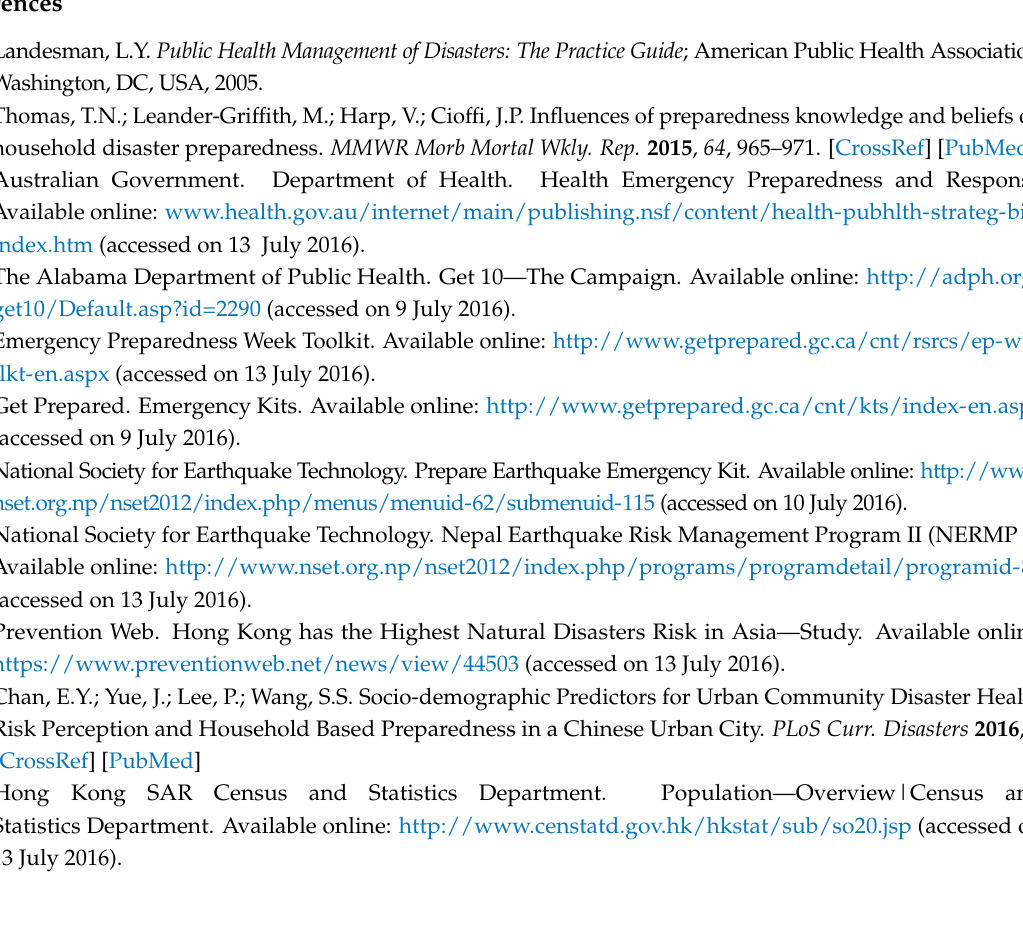
Supplementary Materials: The following are available online at http://www.mdpi.com/1660-4601/15/8/1598/ s1, Figure S1: The proportion of individuals against the number of household preparedness items (mask, alcohol hand rub, antivirals, first aid kit, food and water, basic medication, and long-term medication) at home. Figure S2: Preferred channels (TV, internet, newspaper/magazine, radio, others, health professionals, smartphone/apps, family/friends) to obtain infectious disease information. Figure S3: Preferred channels for providing health information to officials for surveillance Appendix: survey questionnaire. Table S1: Household preparedness of vulnerable